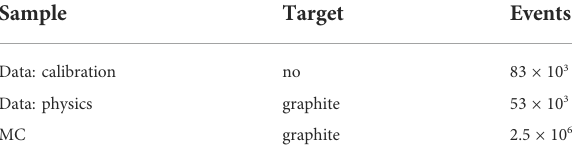
TABLE 1 Available data and MC statistics.